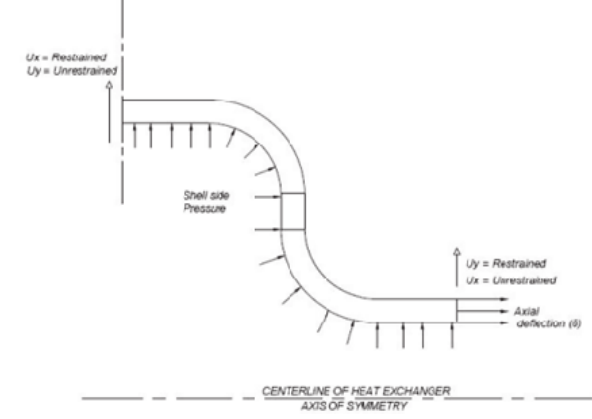
Figure 3: Boundary and loading